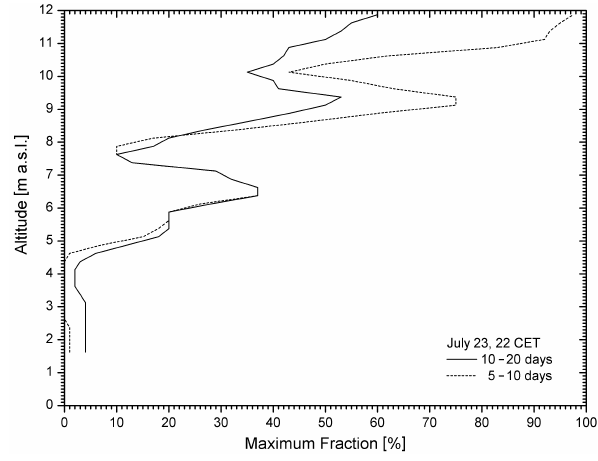
Fig. 17. Vertical distribution of the maximum stratospheric fraction in the retroplume calculated for 23 July, 22:00CET, for two differ- ent backward time